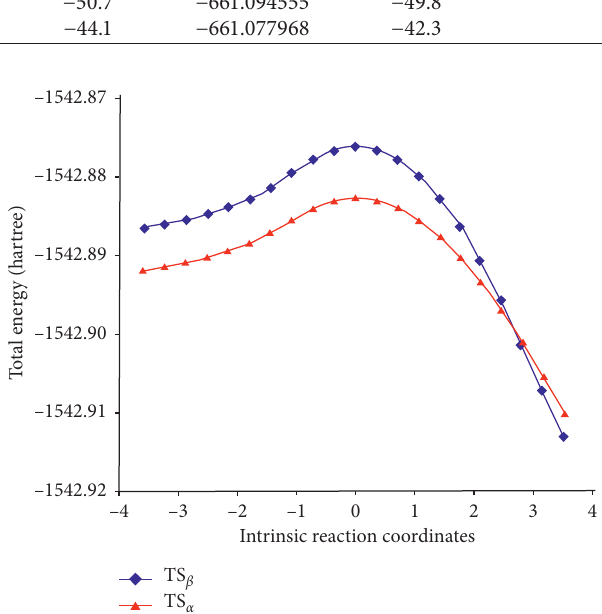
Figure 4: IRC of the reaction between β -himachalene and m- CBPA calculated using DFT at B3LYP/6-311 +G (d, p) level. Structural analysis of the transition states of the